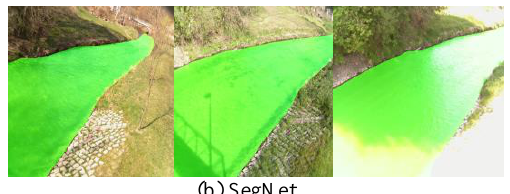
Figure 5. Examples of different illumination conditions in (a) original images; (b) SegNet segmented images.